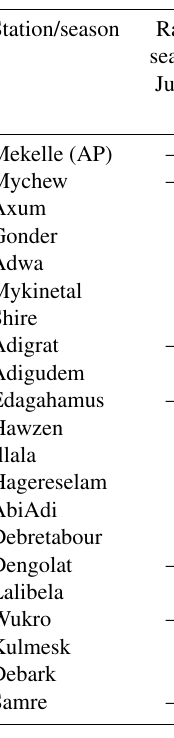
Table 4. Summary results of MK and Z statistics on seasonal and annual rainfall trends. Negative (positive) Z value indicates a de- creasing (increasing) trend, and statistically significant trends at 5% confidence level are shown in bold ( Z =±